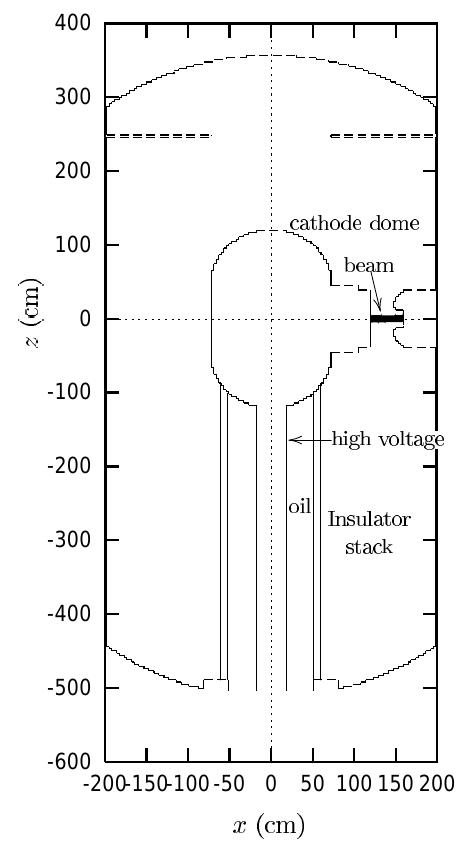
FIG. 1. Injector geometry used in 3D simulations.